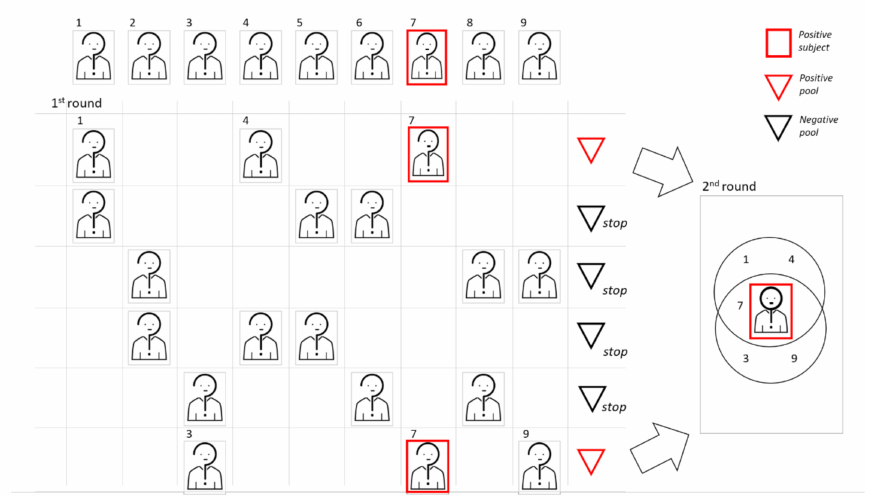
Figure 5. Graphic representation of the combinatorial pooling approach. In this example, two repli- cates of each sample are created and multiple pool with a size of 3 are tested simultaneously. Samples belonging to at least two positive pools are regarded as